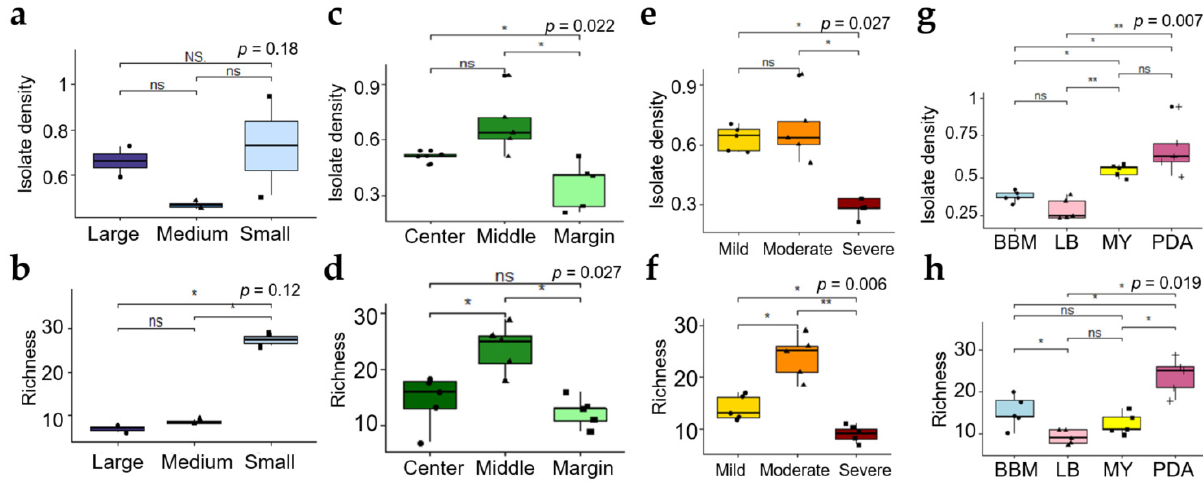
Figure 4. Isolate density and species richness of ELF communities from thallus fragments of different sizes ( a , b ), from different thallus parts ( c , d ), after different sterilization regimes ( e , f ), and on different media ( g , h ); Data of box plots are mean ± s.d. ( n = 5, except for ( a , b ); n = 2); ** p < 0.01, * p < 0.05.